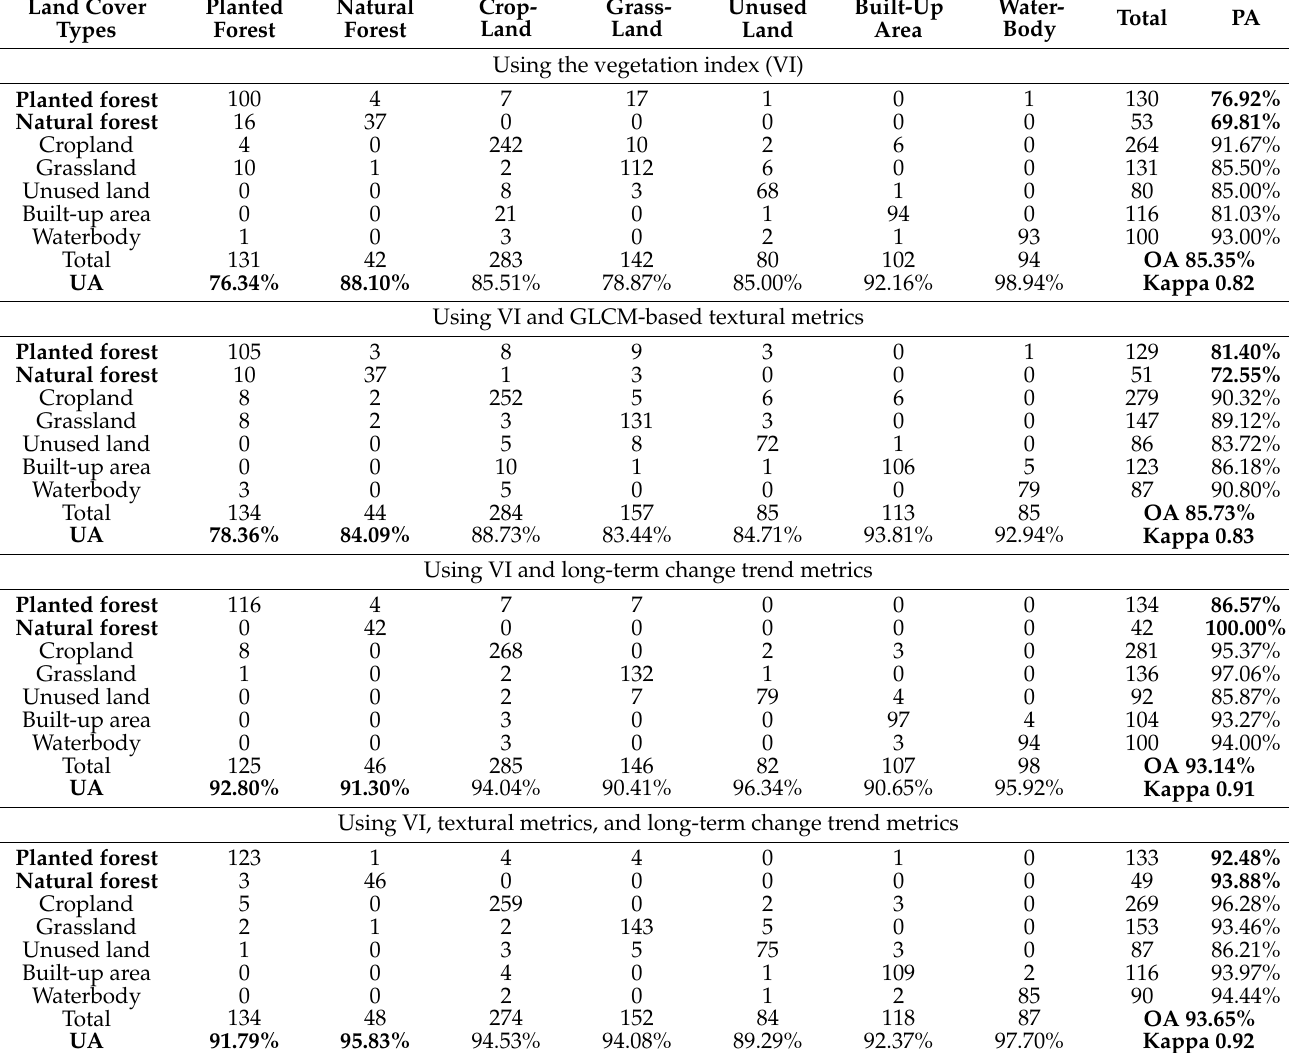
Table 2. User accuracy (UA), producer accuracy (PA), and overall accuracy (OA) of the seven land cover types using the vegetation index (VI), using VI and GLCM-based textural metrics, using VI and long-term change trend metrics, and using VI, textural metrics, and long-term change trend metrics. The PA and UA for the planted and natural forest class, OA, and kappa coefficient were illustrated in